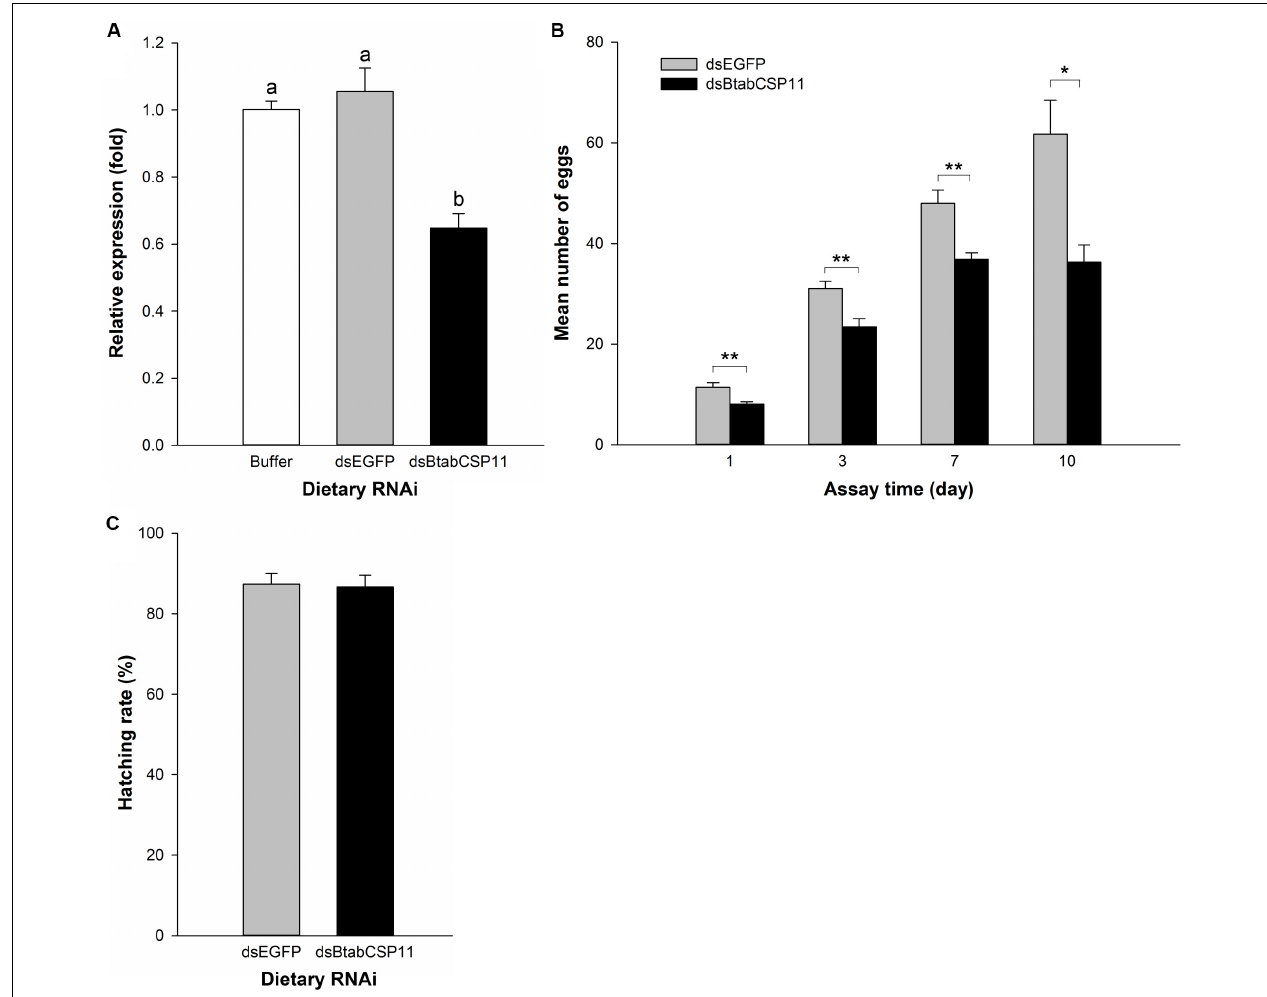
FIGURE 4 | Dietary RNAi-based functional analysis of BtabCSP11 (A) Silencing of BtabCSP11 gene expression by dietary RNAi. Suppression of BtabCSP11 expression after B. tabaci MED adult females fed on dsRNA for 48 h. Expression of the BtabCSP11 gene was detected by RT-qPCR with EF1 – α and actin as the reference genes. Different letters indicate significant differences between treatments ( p < 0.05; n = 3). (B) Effect of BtabCSP11 silencing on B. tabaci female reproduction. Values marked with “*” are significantly different based on one-way analysis of variance (ANOVA with Tukey’s HSD test). (C) Hatching